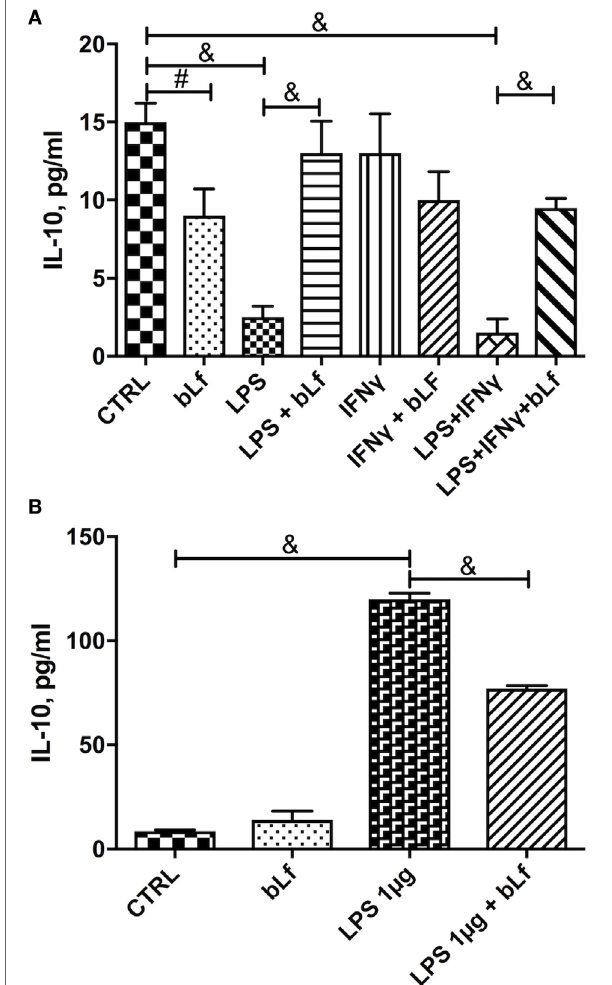
FigUre 3 | Changes in IL-10 levels in THP-1 cells stimulated with (a) a mixture of 20 ng/ml IFN- γ and 10 pg/ml LPS or (B) LPS 1 µg/ml in the presence or absence of 100 µg/ml bovine Lf (bLf) ( # p < 0.05; * p < 0.01; & p <